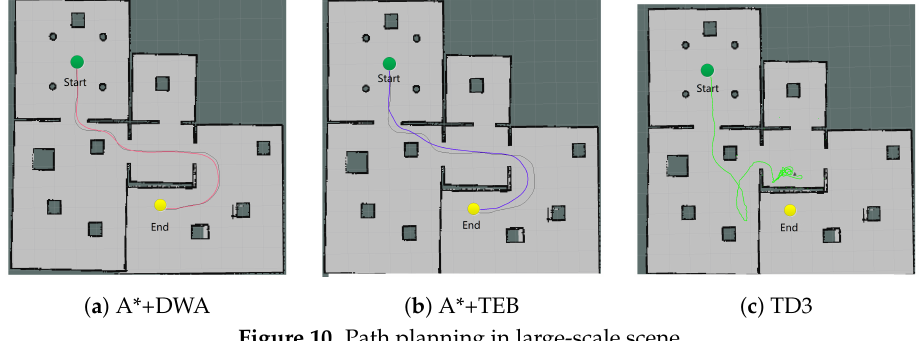
Figure 10. Path planning in large-scale